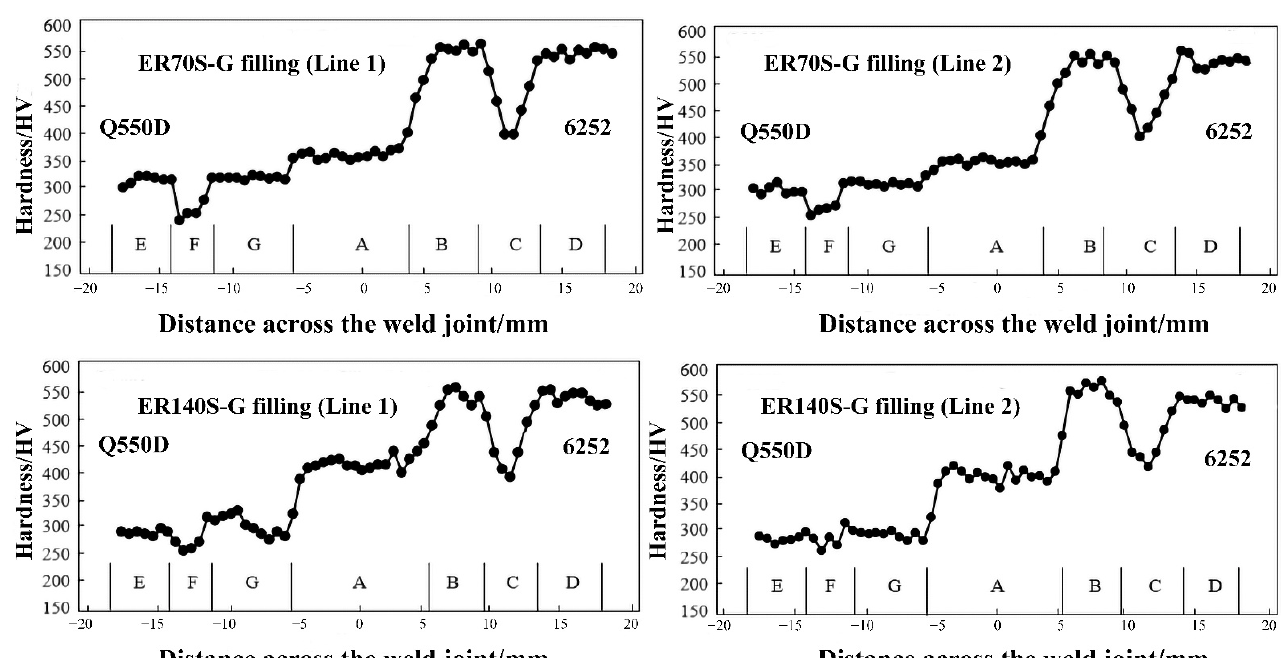
Figure 7. The measured hardness location. Figure 8. Hardness distribution of the weld section. Figure 8. Hardness distribution of the weld